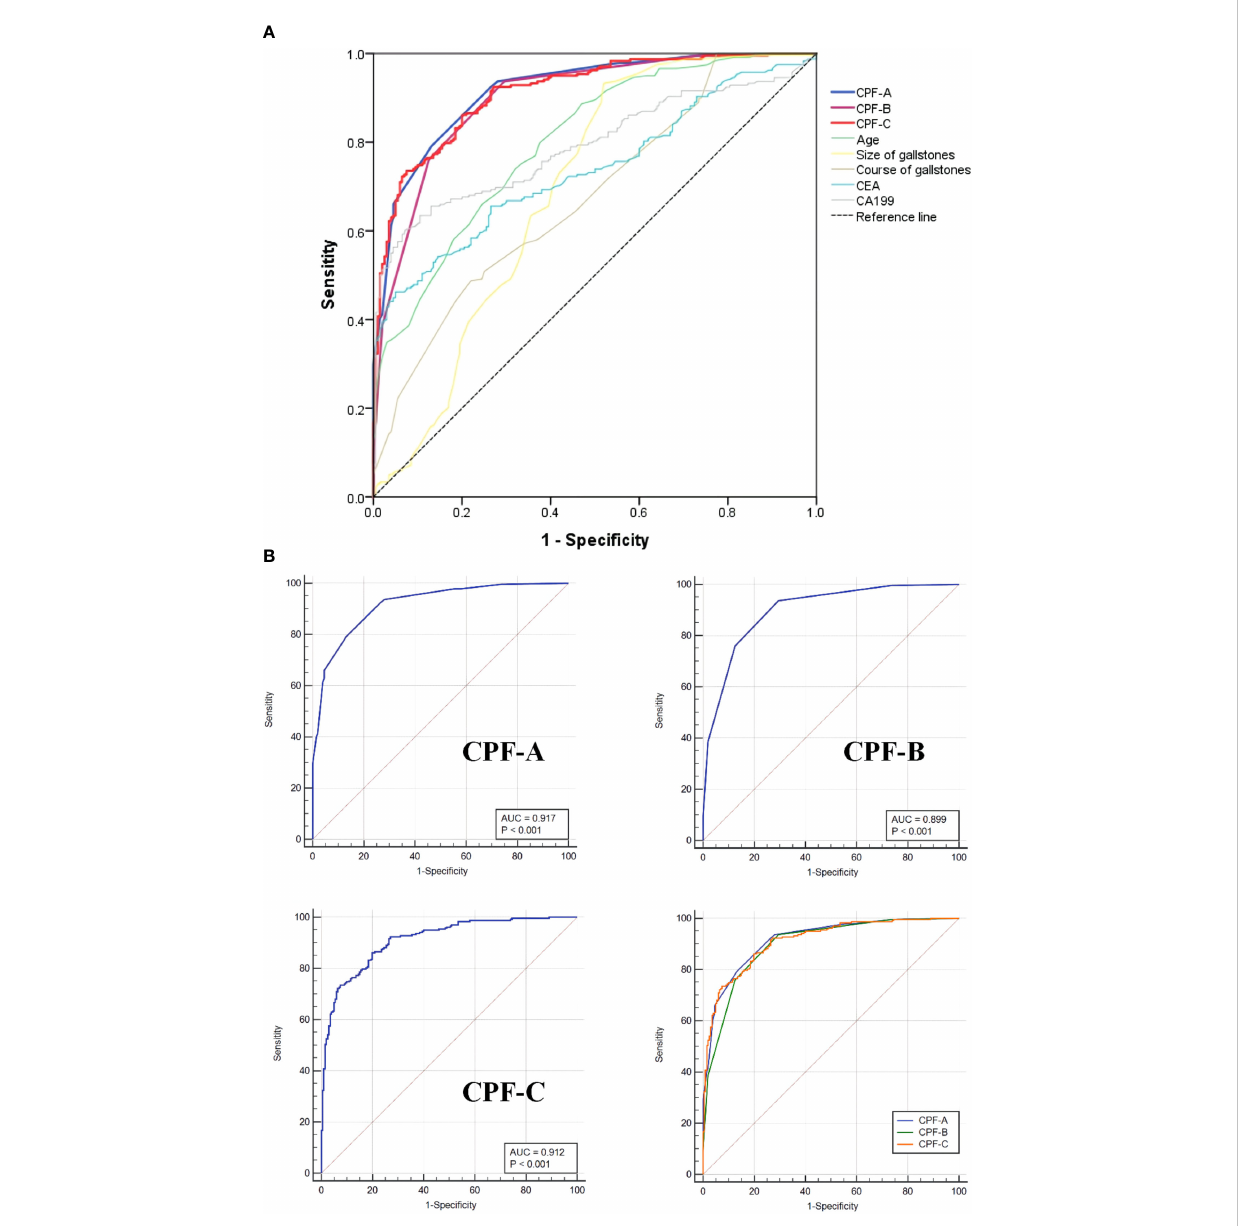
FIGURE 4 The ROC curves of different factors in the internal test samples. (A) The ROC curves of CPF-A, CPF-B, CPF-C and other risk factors associated with GBC. (B) The ROC curves for assessing the discrimination performance of CPF-A, CPF-B and